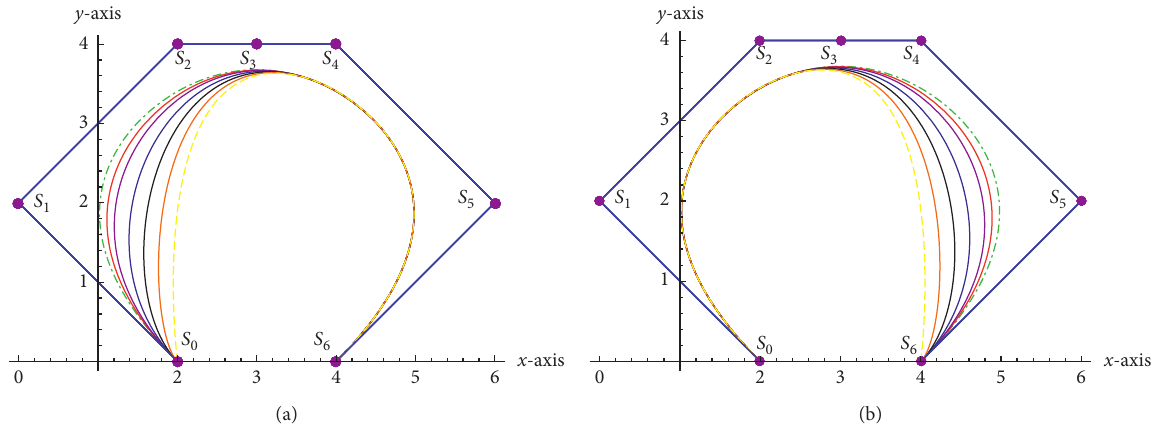
Figure 4: ST-B´ezier curves with different shape parameters. (a) μ � 1 , ω � 1 , 0 . 5 , 0 , − 1 , − 2 , − 3 , − 4. (b) ω � 1 , μ � 1 , 0 . 5 , 0 , − 1 , − 2 , − 3 , −